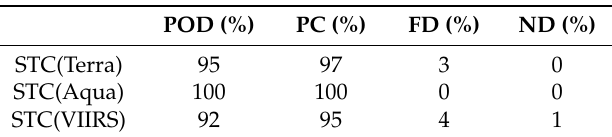
Table 5. Shown are summary error statistics for the 2014–2015, relating to reach-wide ice detection vs. that inferred from hydrometric station data: probability of ice detection (POD), proportion correct (PC), false detection (FD) and non-detection (ND). POD (%) PC (%) FD (%)